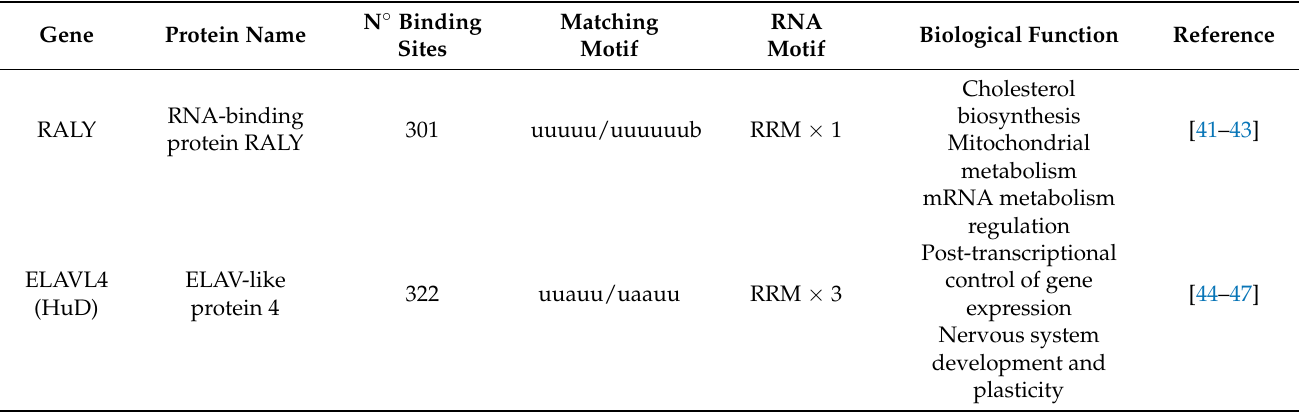
Table 1. Predicted target RBPs of hIDE 3’ UTR, showing the number and type of binding sites and their conservation in